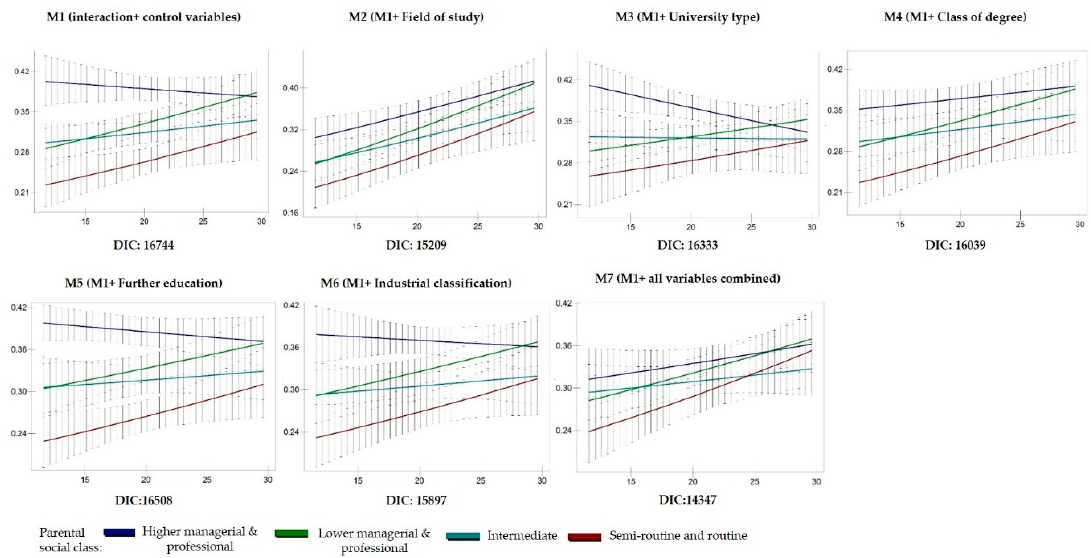
Figure 4. Graduates’ probability of attaining a top-level job by social class of origin and by percentages of professional jobs in the employment area (NUTS 3). Predicted median probability from several two-way interaction models. Note: DIC = Deviance Information Criteria.